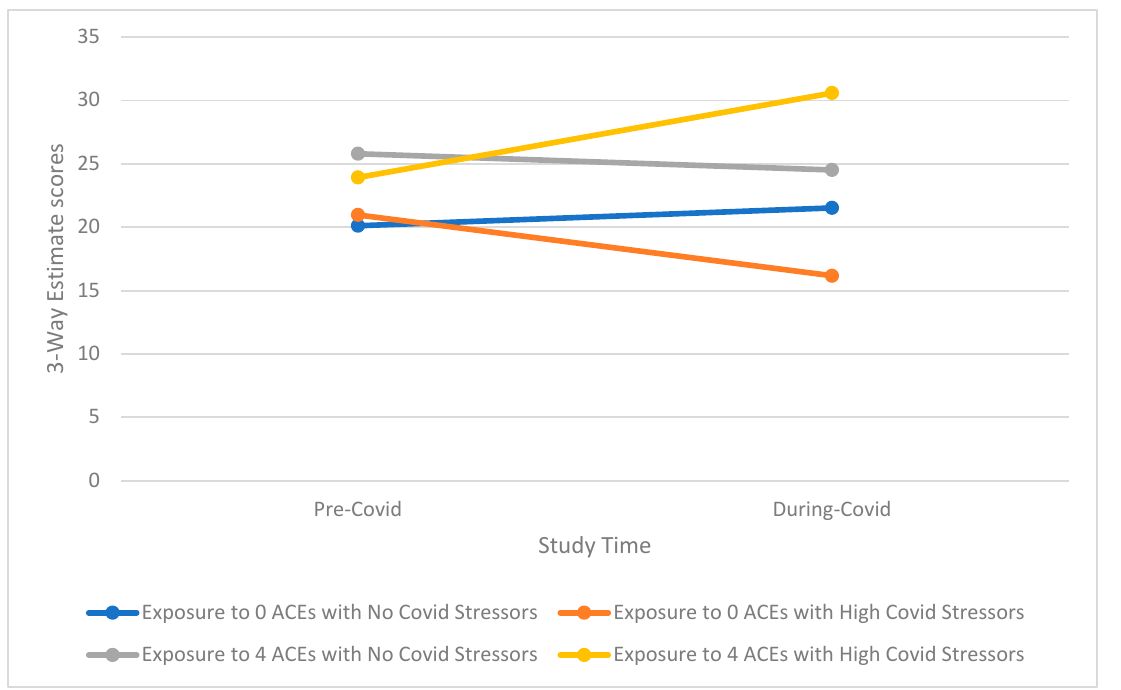
Figure 4. ( a ) Interaction of greater exposure to ACEs and high levels of Serious Arguments with a Roommates on Changes in Hostility Symptomatology among Young Adults from Before to During the COVID-19 Pandemic; ( b ) Interaction of greater exposure to ACEs and high levels of Frustration on Changes in Perceived Stress Symptomatology among Young Adults from Before to During the COVID-19 Pandemic.